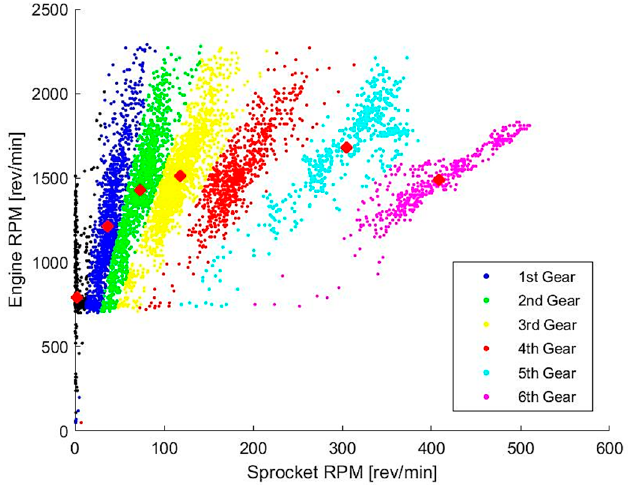
Figure 7. Clustered engine revolutions per minute (RPM) vs. sprocket RPM (single operating session).